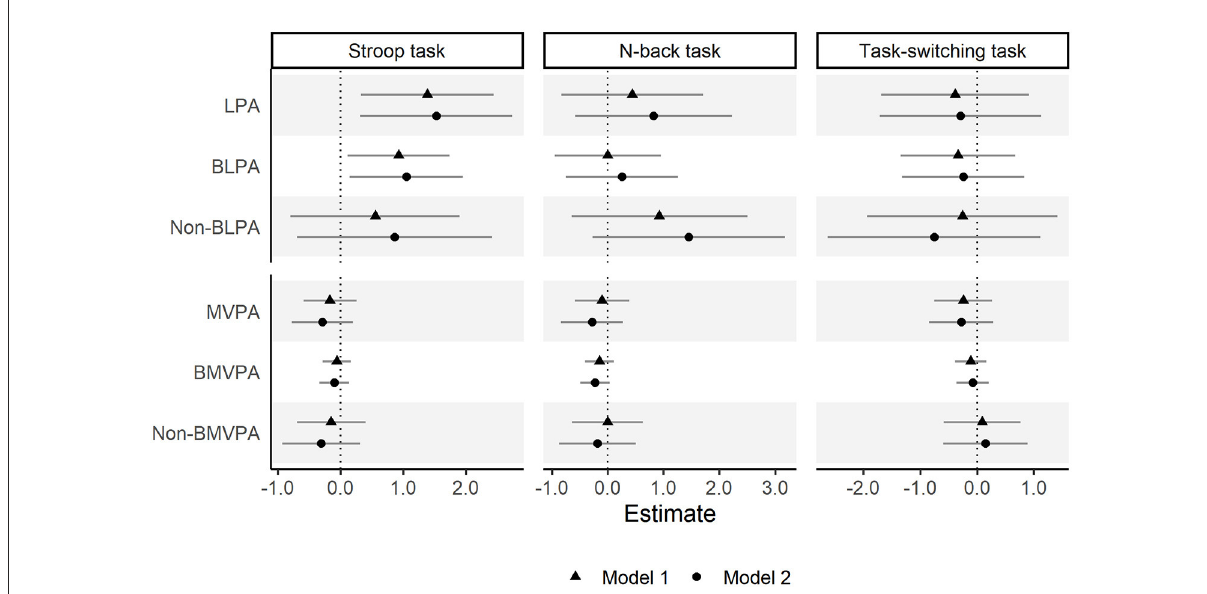
FIGURE1 Associations between physical activity and executive function. Model 1 was adjusted for age, sex, and education year. Model 2 was further adjusted for subjective economic status, living arrangement, frequency of social participation, depressive symptoms, and clinical history (hypertension, diabetes, and heart disease). LPA, light-intensity physical activity; BLPA, bouted LPA; MVPA, moderate- to vigorous-intensity physical activity; BMVPA, bouted MVPA. Balance integration score of Stroop interference, 2-back condition, and global switching cost were used for evaluating Stroop task, N-back task, and task-switching task performance,